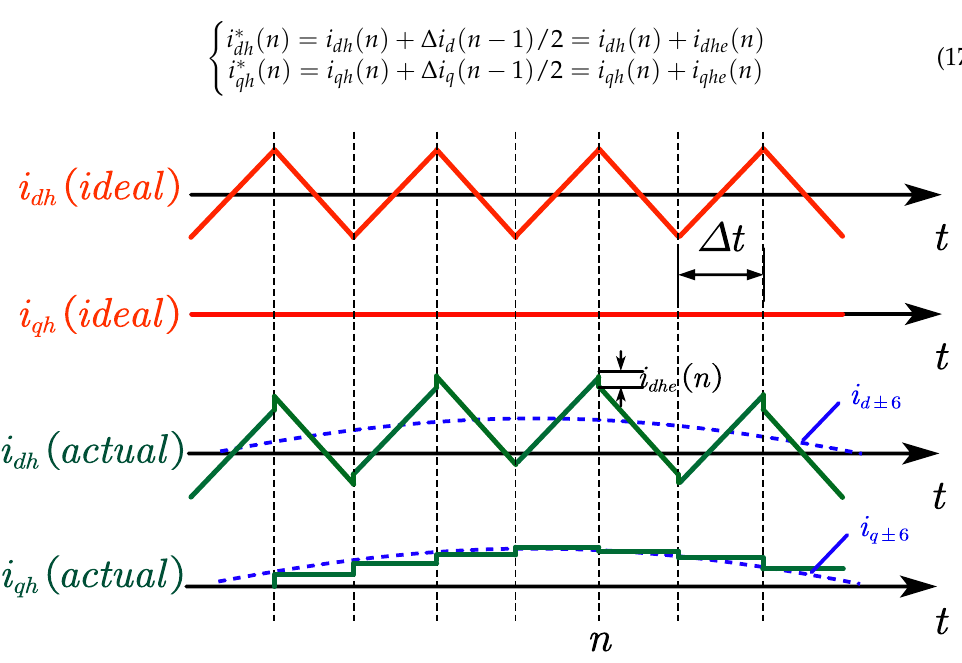
Figure 7. Ideal and actual separated dq-axis HF current.